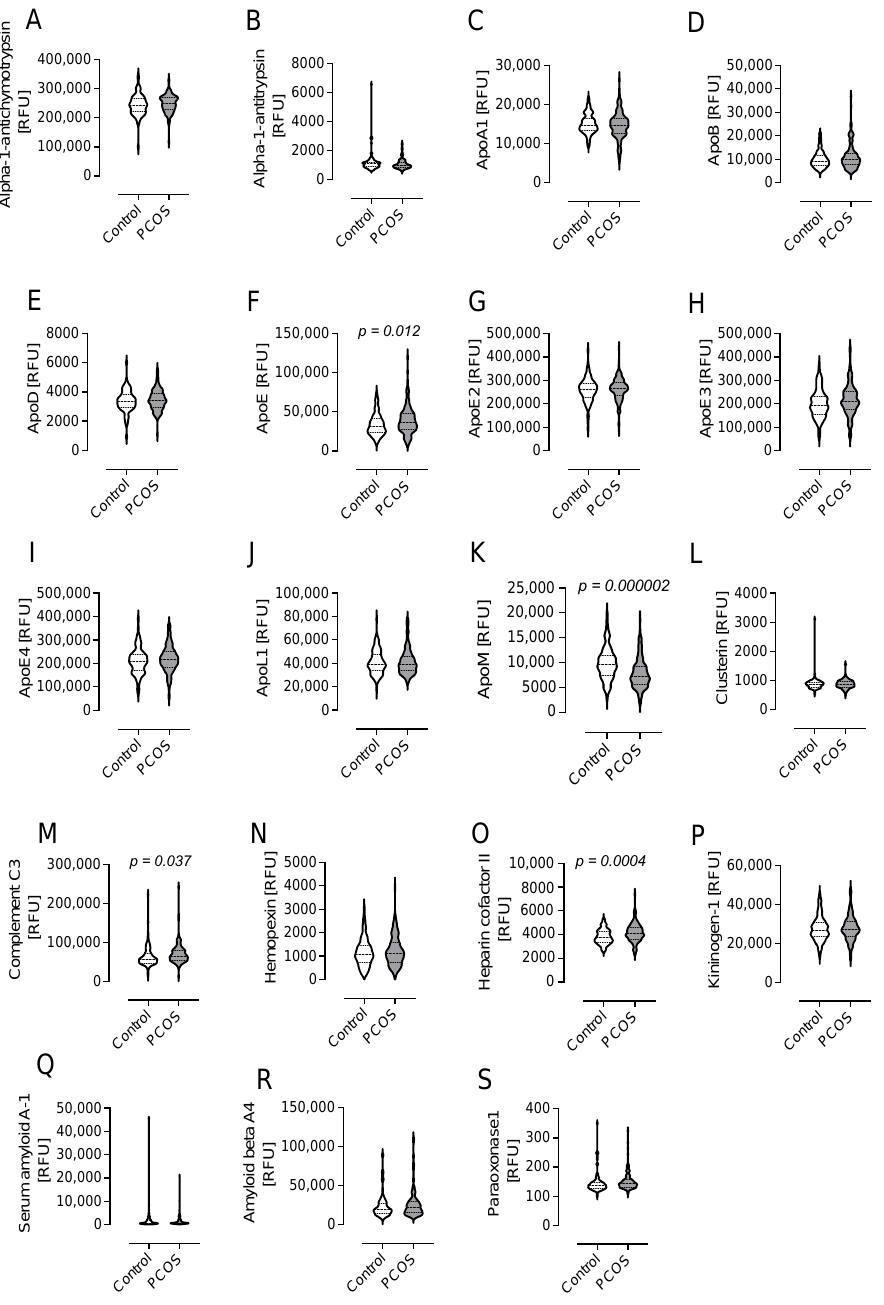
Figure 3. Levels of proteins involved in lipid metabolism in subjects with polycystic ovary syndrome (PCOS) fulfilling all three diagnostic criteria versus controls. Data presented as violin plots with mean ± 1 standard deviation of relative fluorescent units (RFUs). These 19 proteins were alpha-1-antichymotrypsin ( A ); alpha-1-antitrypsin ( B ); apolipoproteins A-1 ( C ), B ( D ), D ( E ), E ( F ), E2 ( G ), E3 ( H ), E4 ( I ), L1 ( J ), and M ( K ); clusterin ( L ); complement C3 ( M ); hemopexin ( N ); heparin cofactor II ( O ); kininogen-1 ( P ); serum amyloid A-1 ( Q ); amyloid beta A-4 ( R ); and paraoxonase-1 ( S ).